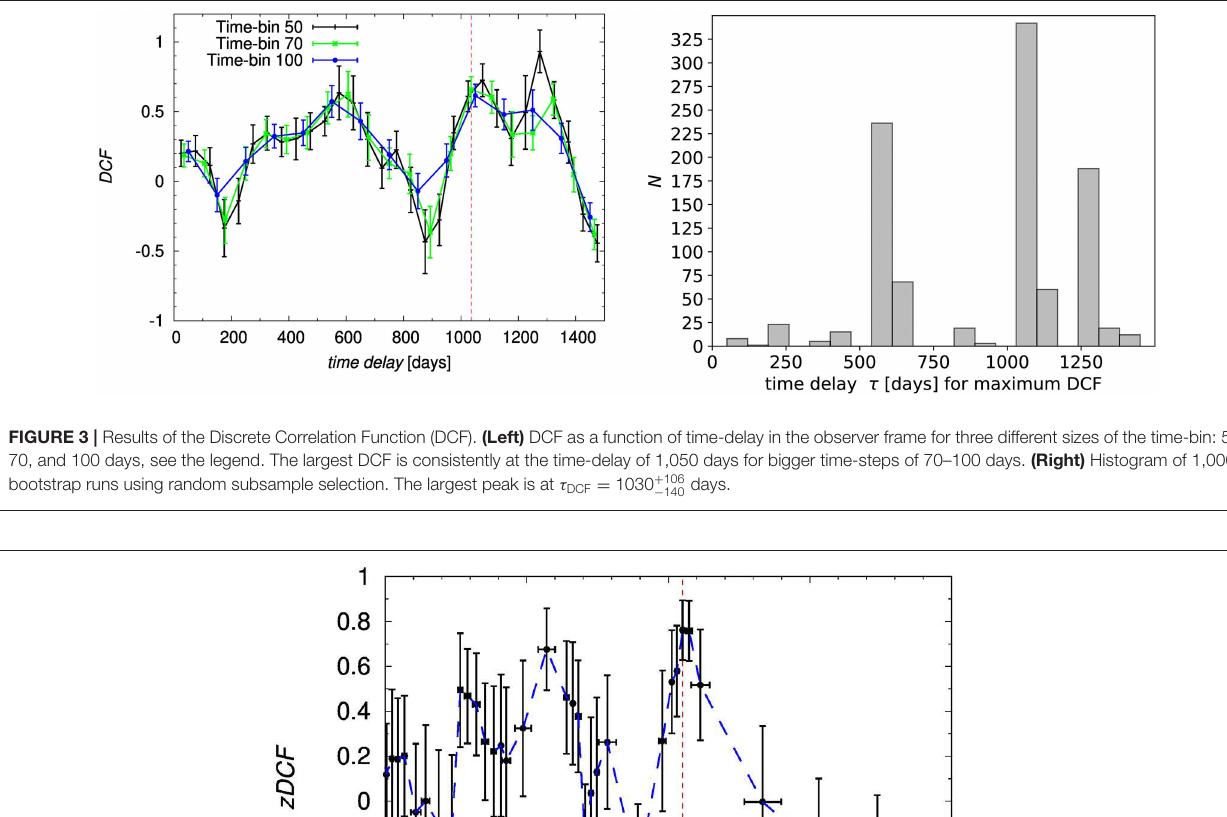
FIGURE 4 | Results of the z -transformed discrete correlation function (zDCF). We show the zDCF as a function of the time-delay in the observer frame. The red vertical dashed line marks the time-delay with the largest value of a zDCF coefficient.